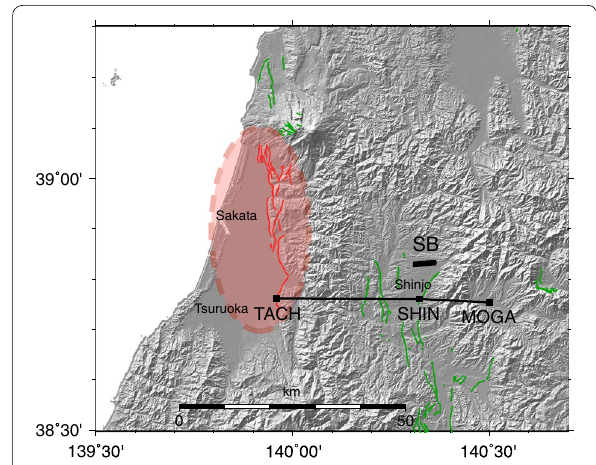
Fig. 4 Local map of the source region of the 1894 Shonai earthquake. The red lines denote the Eastern Shonai Plain fault zone. The pink ellipse denotes the area of severe damage (seismic intensity 5 or larger). SB denotes the location of the Shionohara baseline. + MOGA, SHIN, TACH are the GEONET stations